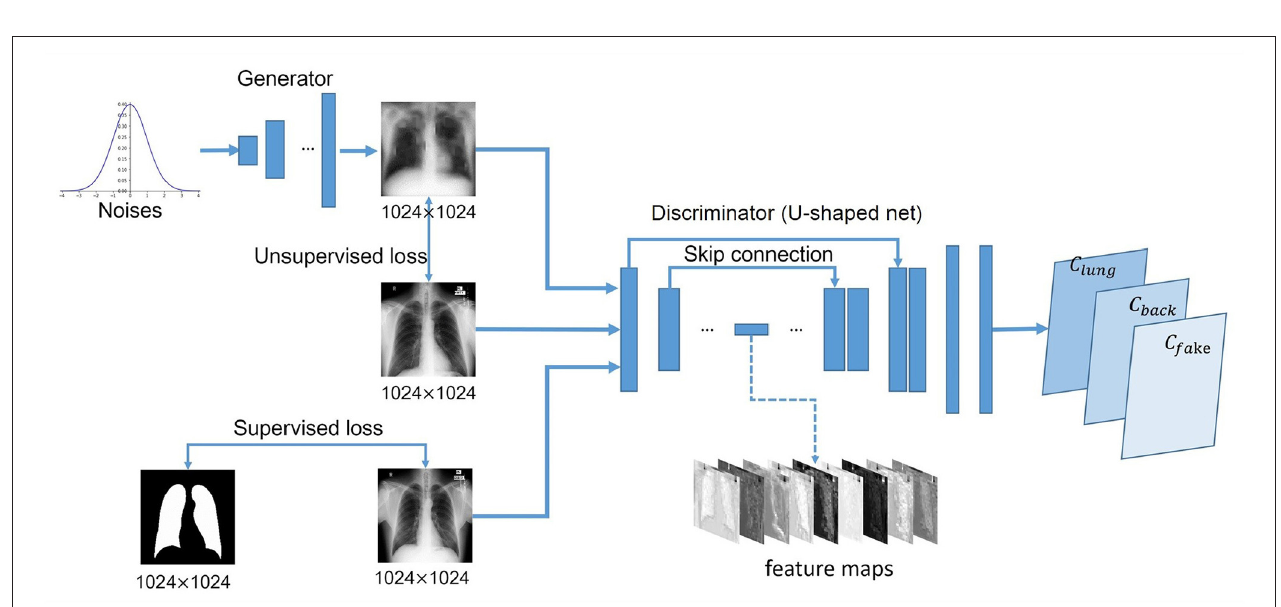
FIGURE 2 | Schematic description of U-shaped GAN. The generator transforms noise into fake images. The fake and real data are used to train the discriminator for pixel-level predictions as lungs C lung , background C back , and fake C fake .